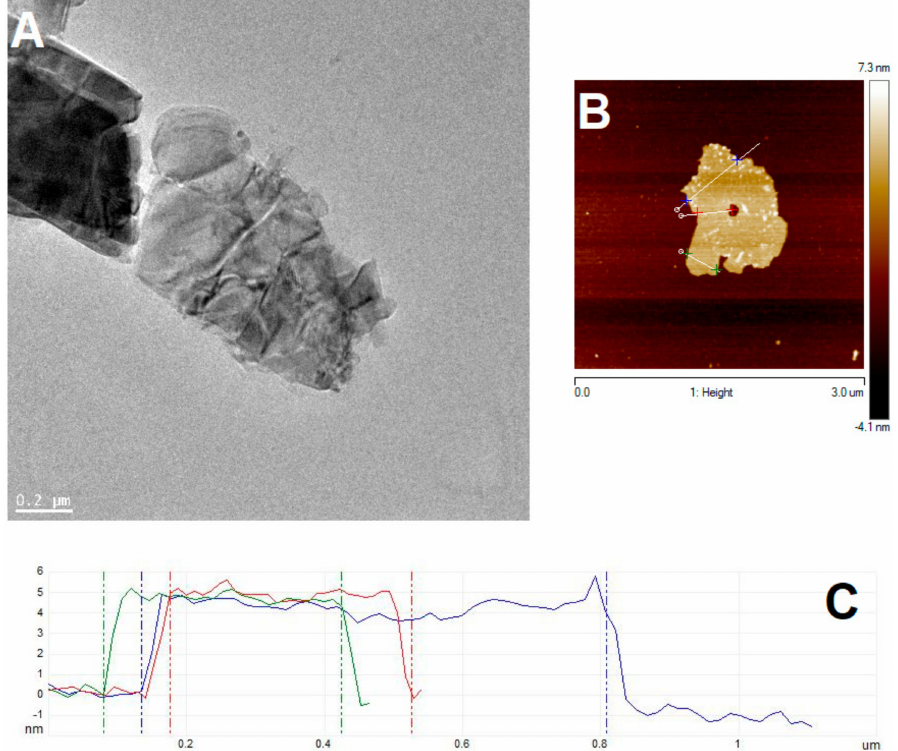
Figure 1. Transmission electron microscopy (TEM) ( A ) and atomic force microscopy (AFM) ( B ) images, along with AFM height profiles ( C ) of few-layered MoS